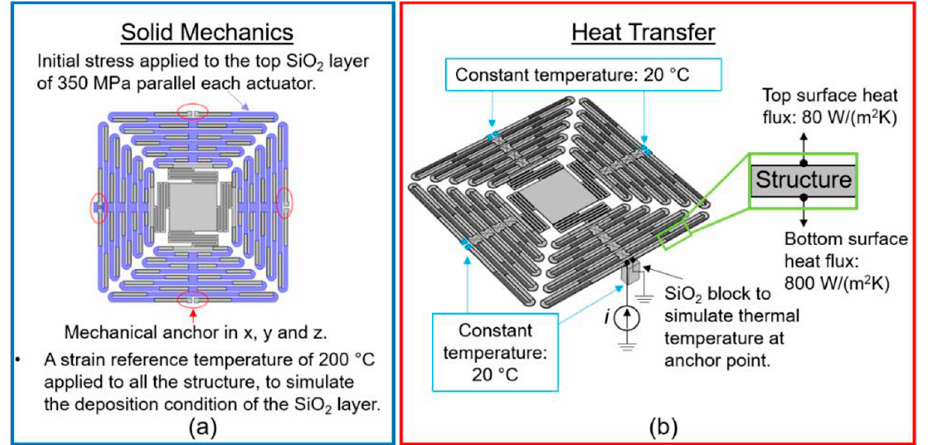
Figure 2. Boundary conditions for the FEM simulations: ( a ) solid mechanics model and ( b ) heat transfer model. The solid mechanics model only focused on the stress levels of the material layers to achieve an initial out-of-plane deflection. The heat transfer model only focused on the steady state behavior of the temperature resulting from joule heating due to a bias current passing through the metal